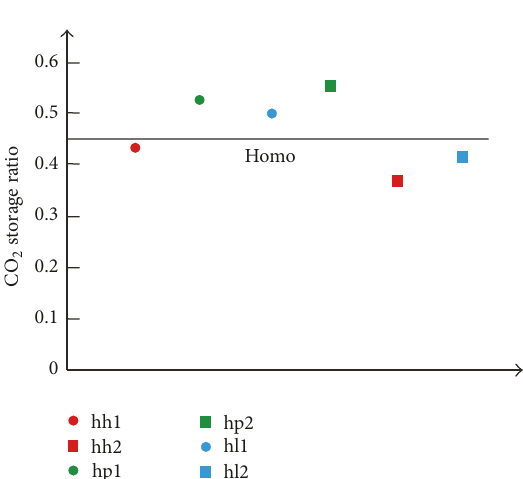
Figure9:StorageratioofCO 2 inreservoirafter20yearsfordifferent